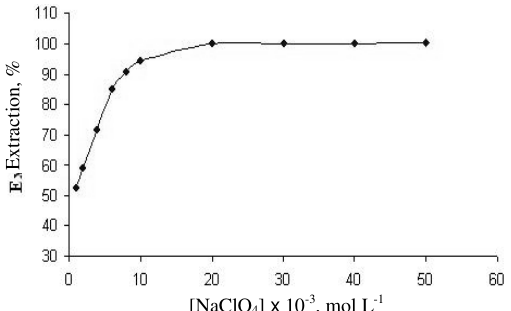
Figure 4. Effect of ClO 4- concentration on the extraction of palladium. ( Conditions: Pd(II) 50.0 ng mL -1 ; TMK 5.0 × 10 -5 mol L -1 ; CHCl 3 60.0 µL; TBA + 2.0 × 10 -2 mol L -1 and pH=3.0 ).